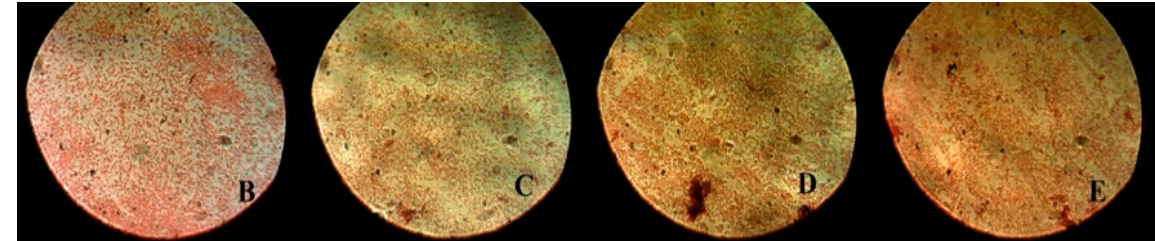
Figure 4. Characterization of bacterial colonies after sample inoculation for groups B, C, D, and E using an optical microscope (OPTIKA, B-600Tiph, Italy, 100×/1.25× oil PH, PLAN).